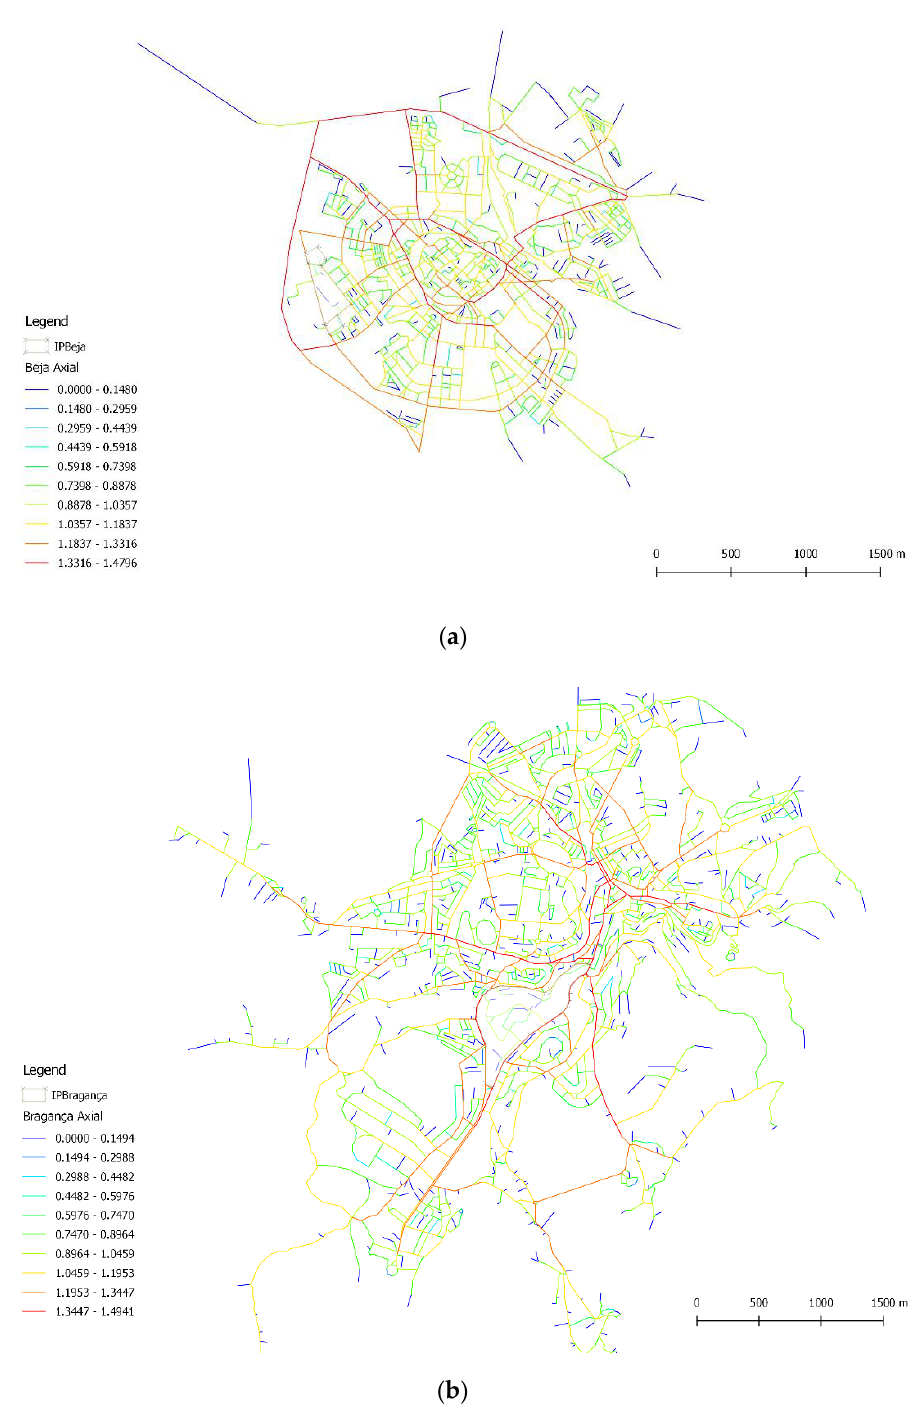
Figure 4. Segment maps — normalized angular choice (NACH) Rn: ( a ) Beja; ( b ) Bragança.